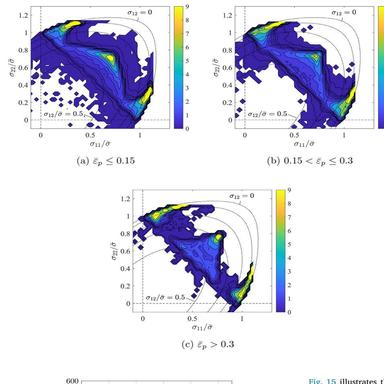
Probability density function of the experimental stress states on the yield surface locus at different levels of accumulated equivalent plastic strain ̄.